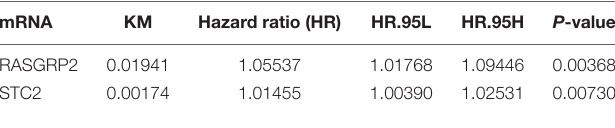
TABLE 3 | Survival analysis according to the Kaplan-Meier method and the Cox method for 67 shared mRNAs in TCGA profile.